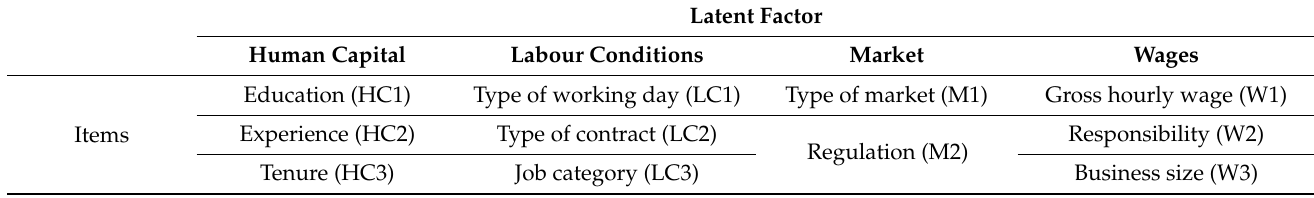
Table 1. Constructs and indicators of the structural equation